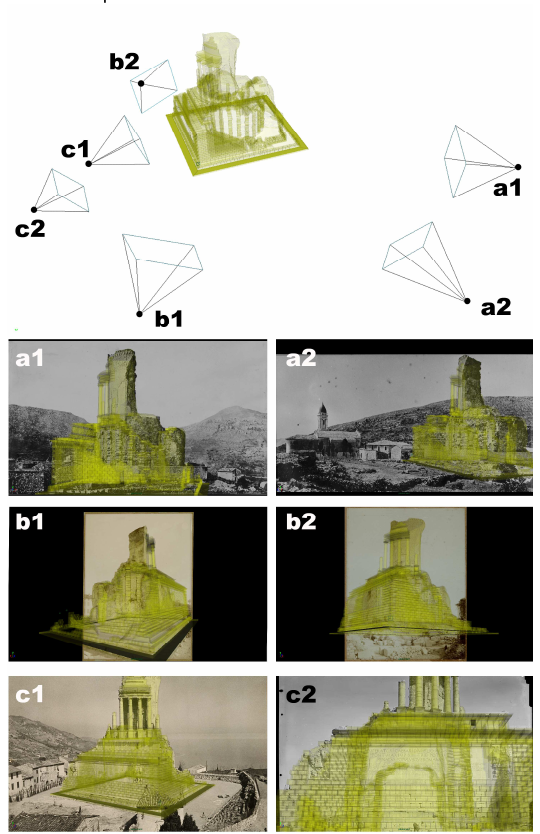
Figure 4. Spatial referencing of historic photos on the 3D model of the building current